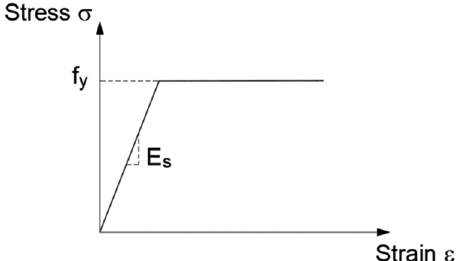
Figure 15: Stress – strain relationship for steel.